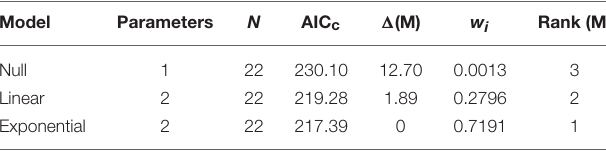
TABLE 2 | Summary of model selection results for the relationship between activity and body size in hermaphroditic shrimp of L. wurdemanni . Model